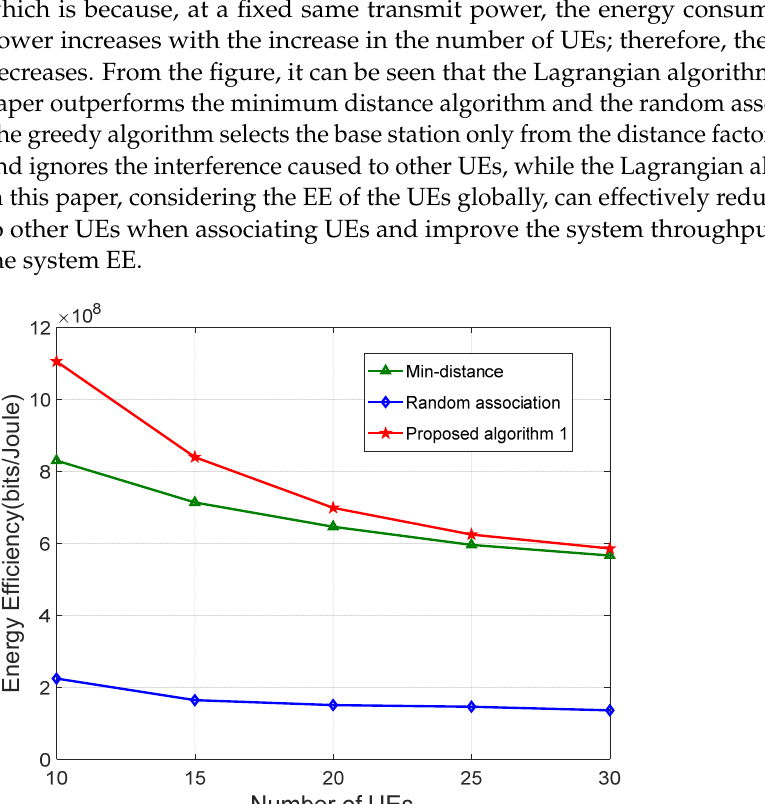
Table 3. Joint resource allocation scheme.